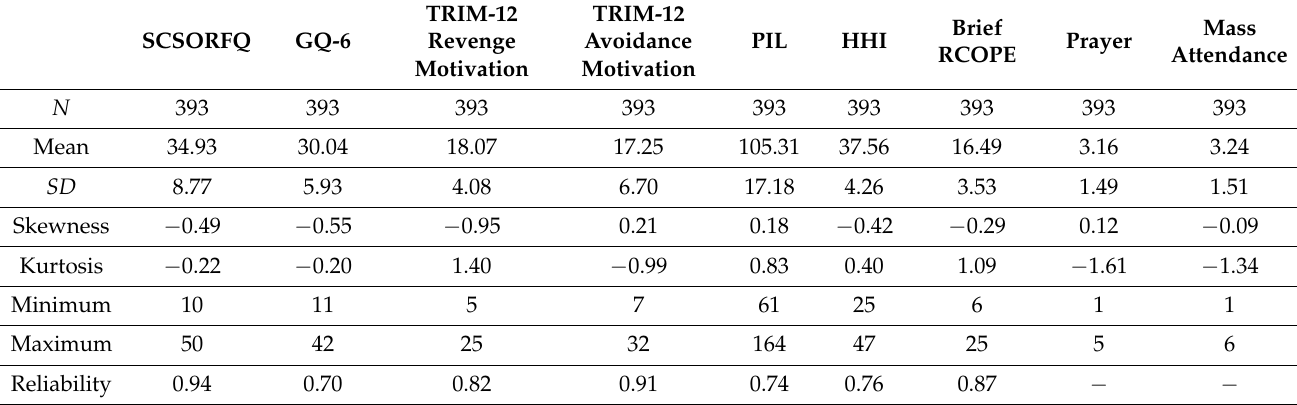
Table 1. Descriptive statistics for the study